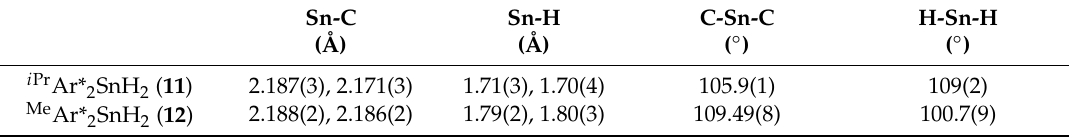
Table 3. Selected bond lengths (Å) and angles ( ◦ ) of diaryltin dihydride compounds 11 and 12 .